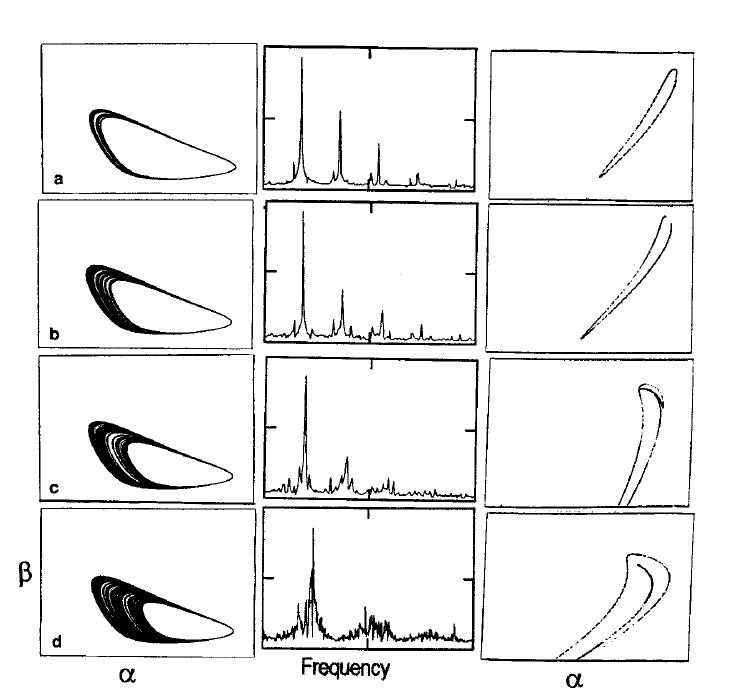
Figure 5. Numerical oscillatory responses of glycolysis under periodic substrate input flux showing a transition sequence to chaos through quasiperiodicity. In the first column are represented the corresponding attractors (projections in two dimensions for the  concentration, x-axis, and the  concentrations, y-axis), power spectra in the second column and Poincaré sections in the  ,  plane (third column). Reproduced with permission from Elsevier